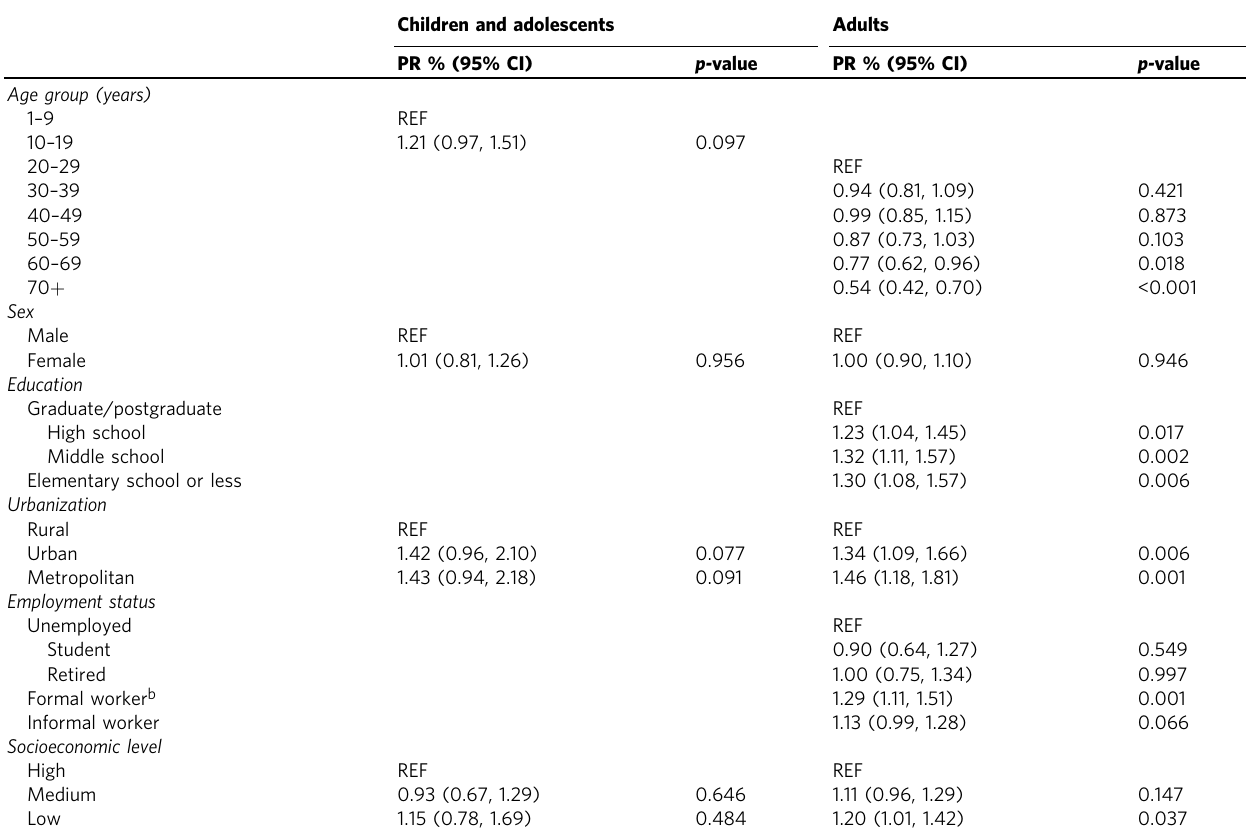
Table 2 Sociodemographic factors associated with seropositivity to antibodies anti SARS-CoV-2 in Mexico, 2020. Multivariable Poisson regression models a .